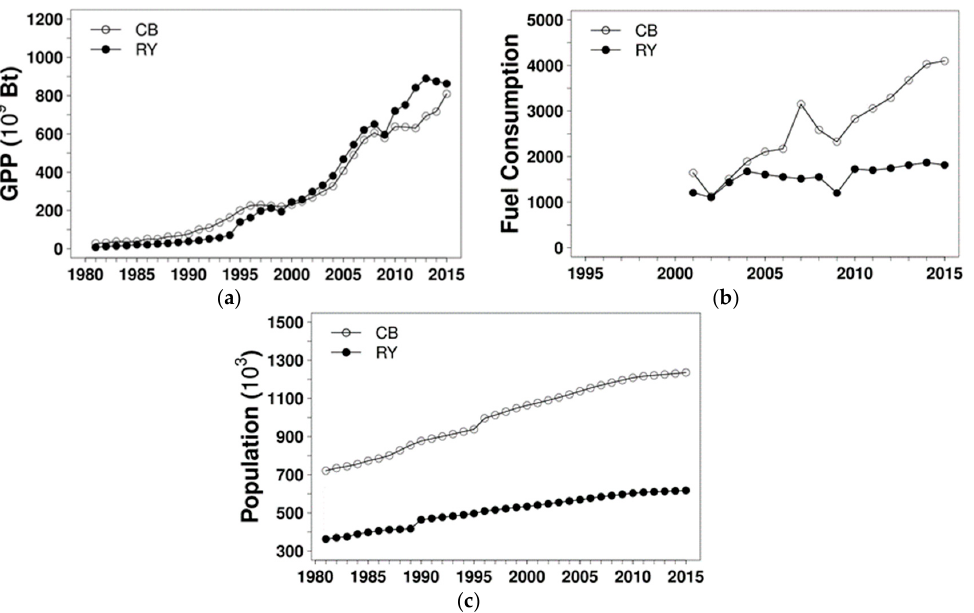
Figure 2. ( a ) gross provincial product (GPP) (at current market price); ( b ) fuel consumption (ktoe, 1 ktoe = 41,868 × 10 9 J); and ( c ) registered population for Chon Buri and Rayong provinces, Thailand.